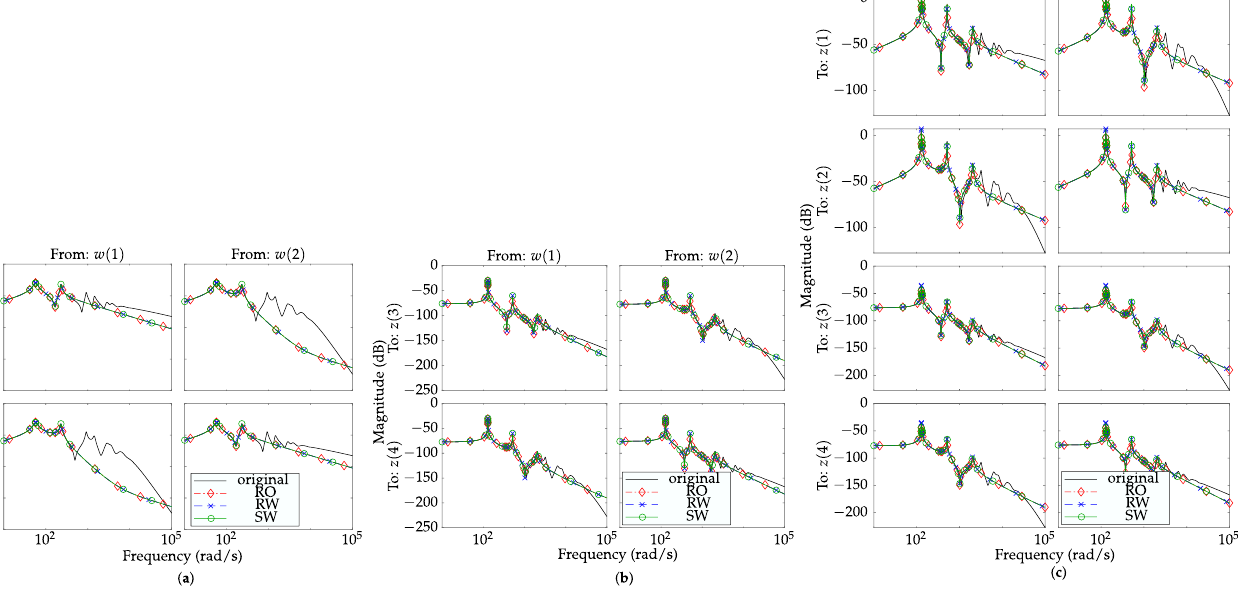
Figure 9. Frequency response of the original (unreduced) interconnected system compared to RO (Reduced Order with initially calculated weights W j ,1 ), RW (reduced order with Refined Weights W j ,1 e ) and SW (reduced order with Static Weights W j ,1 s ). ( a ) Case #1, beams mutually interconnected only by dampers, representing a highly dissipative case. ( b ) Case #2, beams mutually interconnected only by springs, representing the least dissipative (stiffest) case. ( c ) Case #3, beams mutually interconnected by both dampers and springs, representing the most complex interconnections case (with most uncertainty